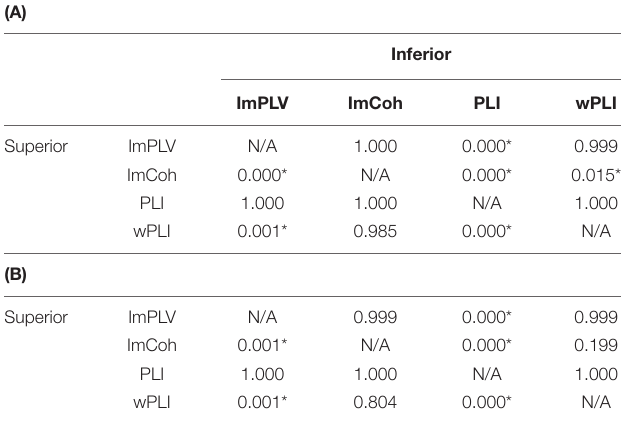
TABLE 1 | Results of the post hoc analysis of differences in the true positive rates between each pair of the functional connectivity measures when the number of trials was 100 (A) and 200 (B)